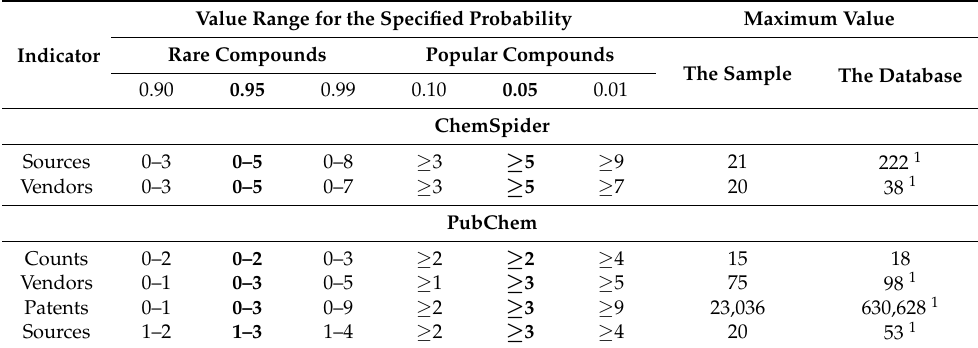
Table 3. Limits of subset ranges of rare and popular compounds. Value Range for the Specified Indicator